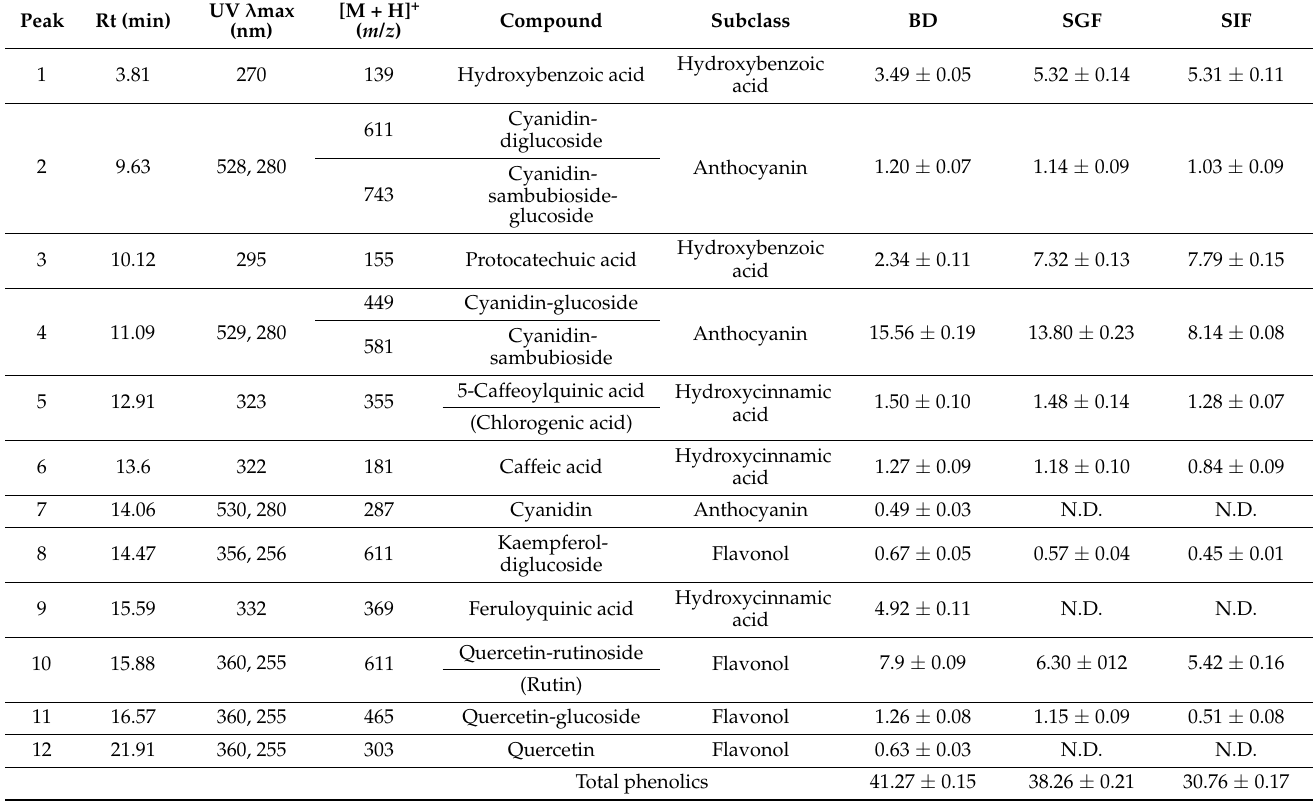
Table 3. The in vitro effect of gastrointestinal digestion on the phenolic content of EB